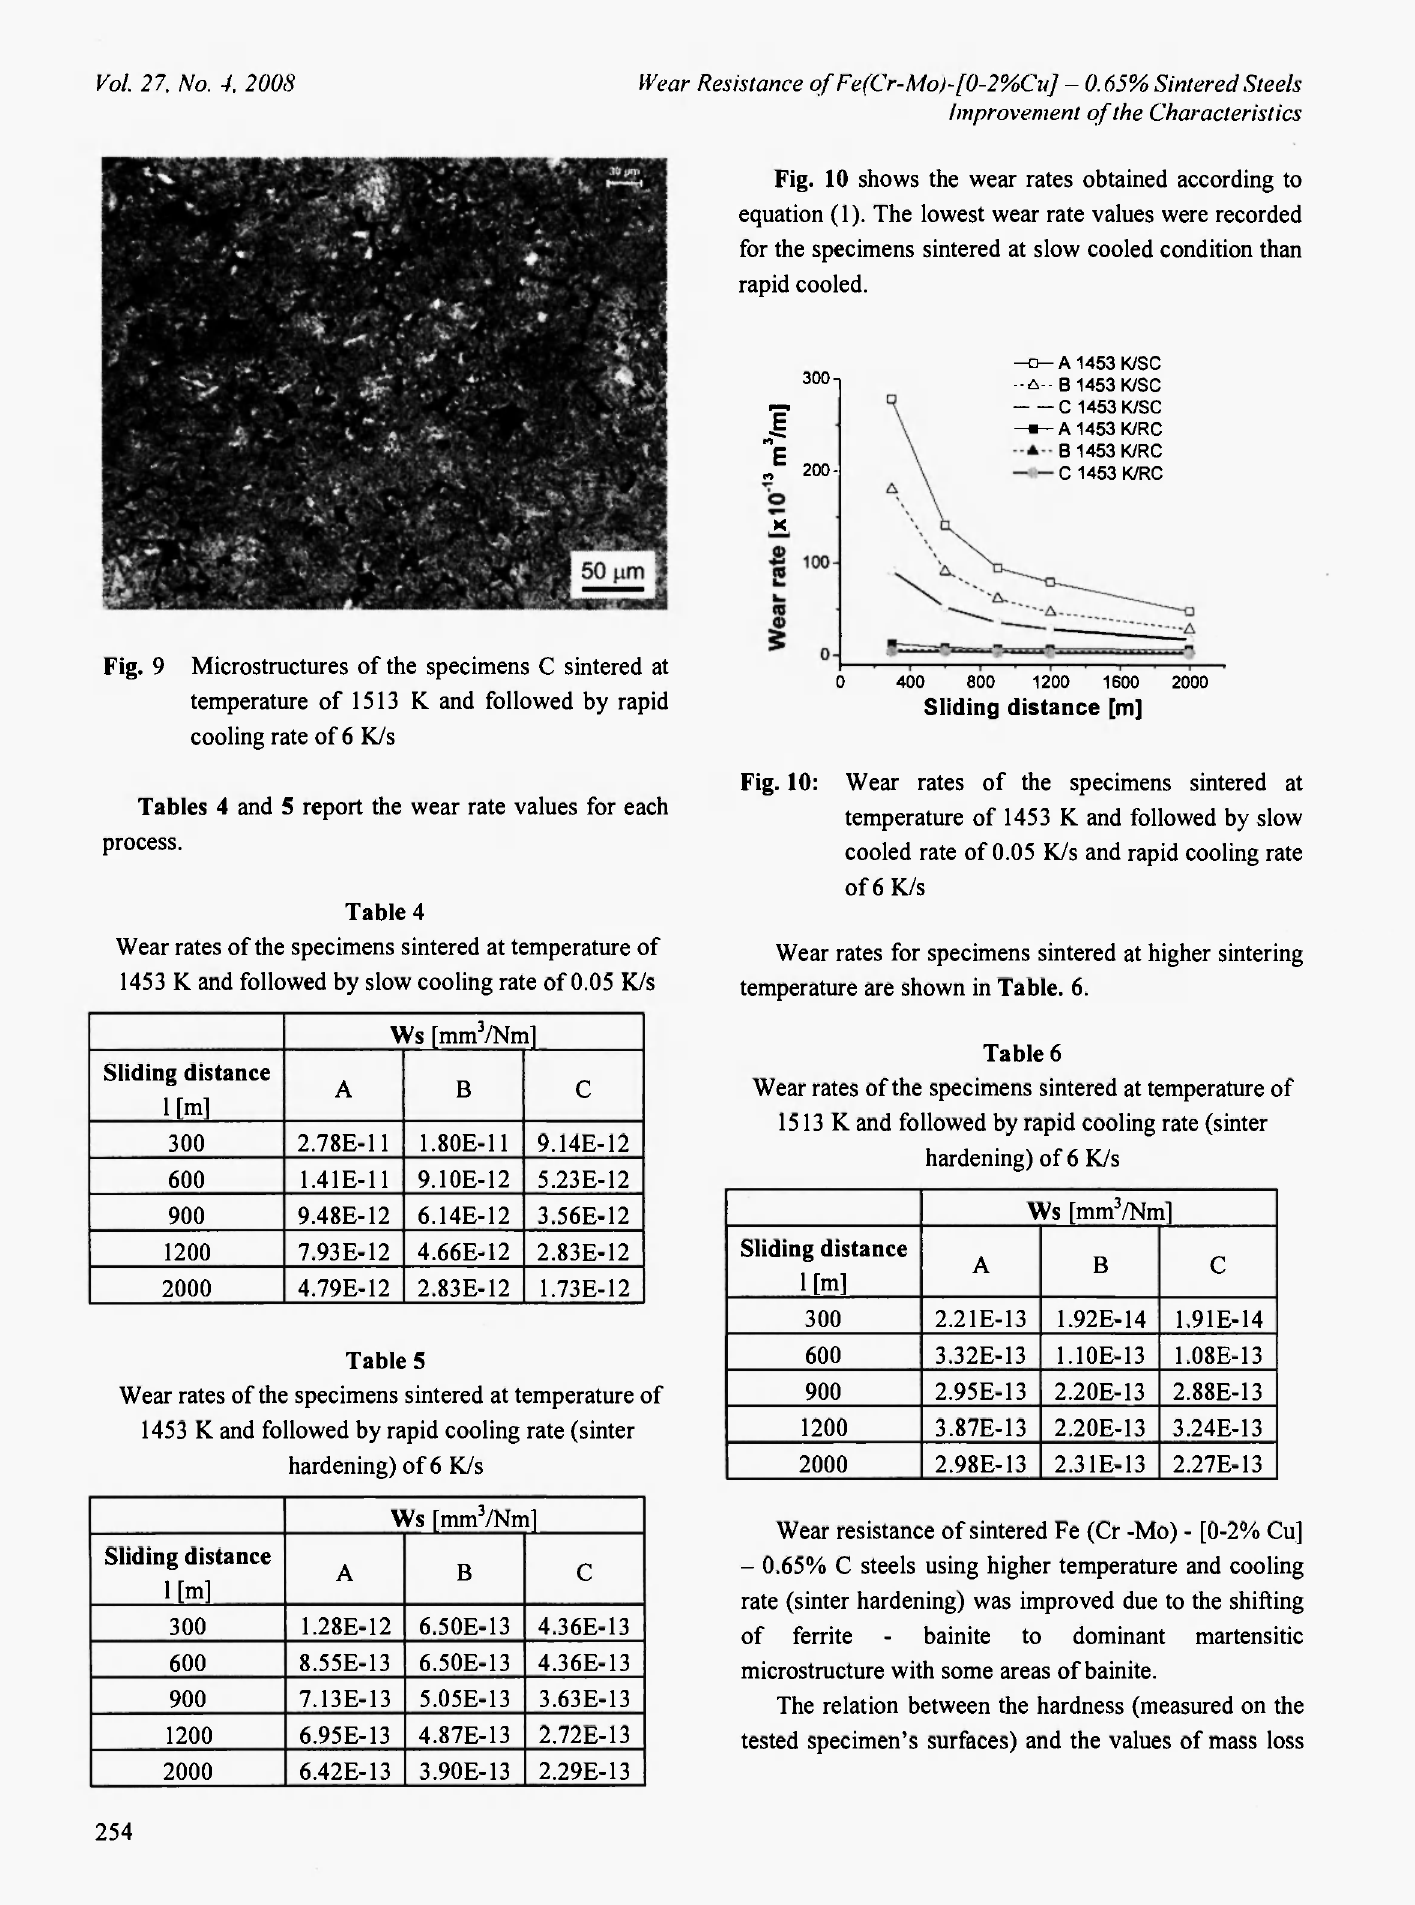
rate (sinter hardening) was improved due to the shifting of ferrite bainite to dominant martensitic microstructure with some areas of bainite. The relation between the hardness (measured on the tested specimen's surfaces) and the values of mass